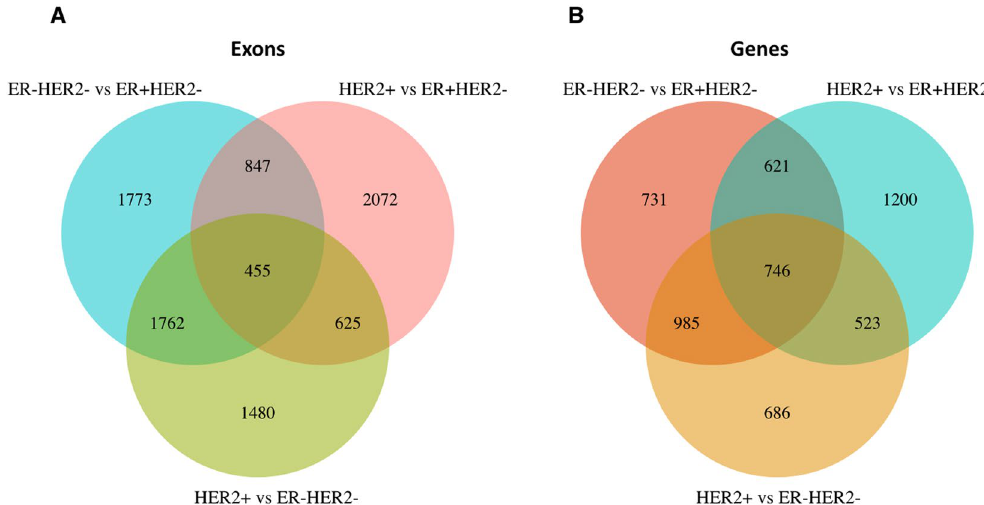
lower log 2 FC ( − 1) in the ER + HER2 − group when compared to NBS, and higher ( + 1, final score 9778) in